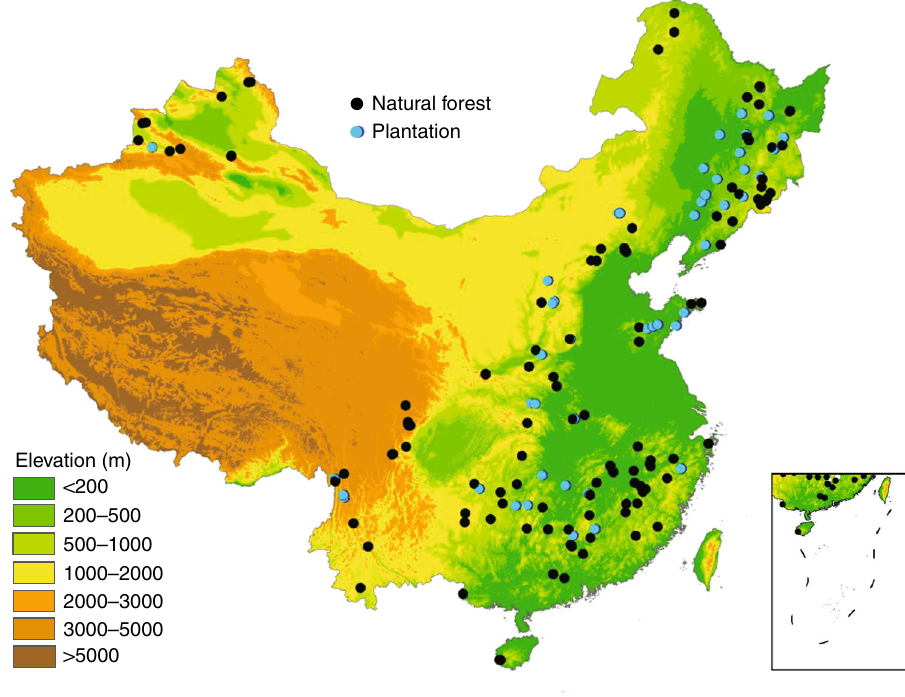
Fig. 1 Distribution of 189 sampling sites in this study. The sites include 128 natural forests (65 primary forests and 63 secondary forests), and 61 plantations. For details, see Supplementary Data